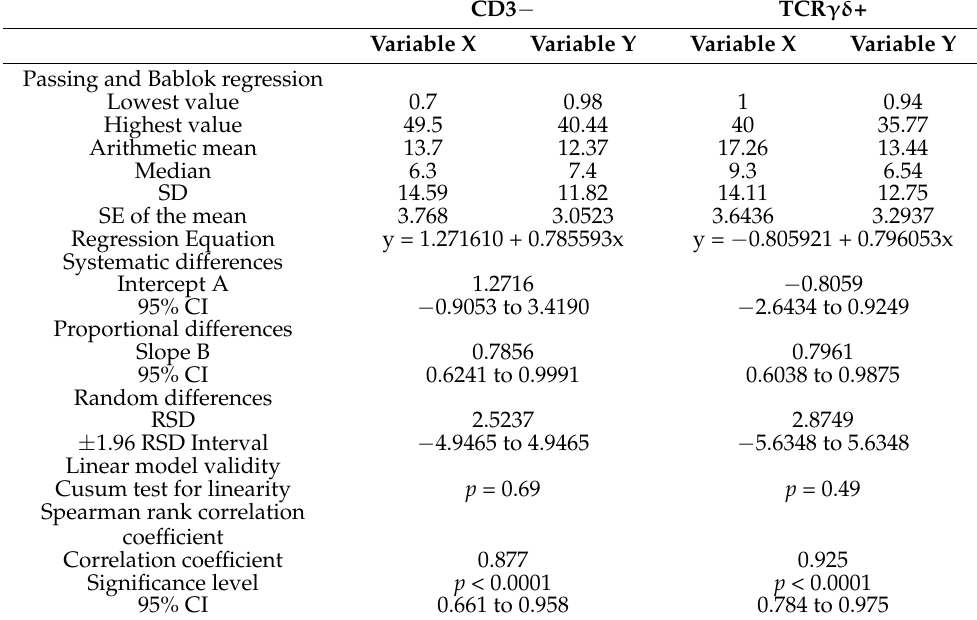
Table A3. Comparison of the different lymphocyte subpopulation data obtained in two different centres with different flow cytometers ( n = 15). Variable X shows data obtained in the reference centre (Hospital Ram ó n y Cajal) with the BD FACSCanto cytometer and variable Y shows data obtained in CATLAB with the BD FACSCalibur